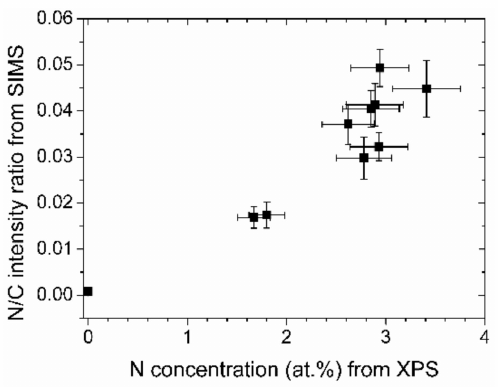
Figure 5. Absolute and relative nitrogen concentrations of the (N-)DLC samples from XPS and SIMS measurements, respectively.